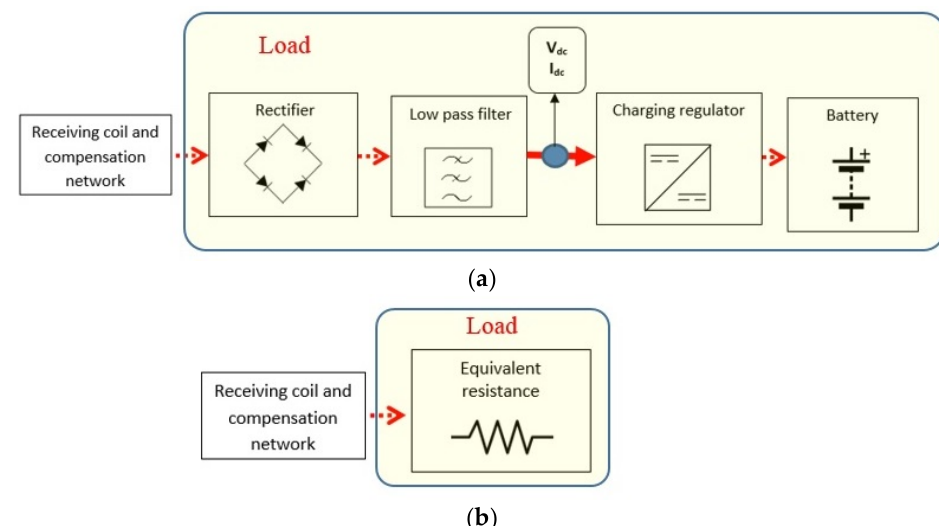
Figure 2. Load model: complete ( a ) and simplified ( b ).